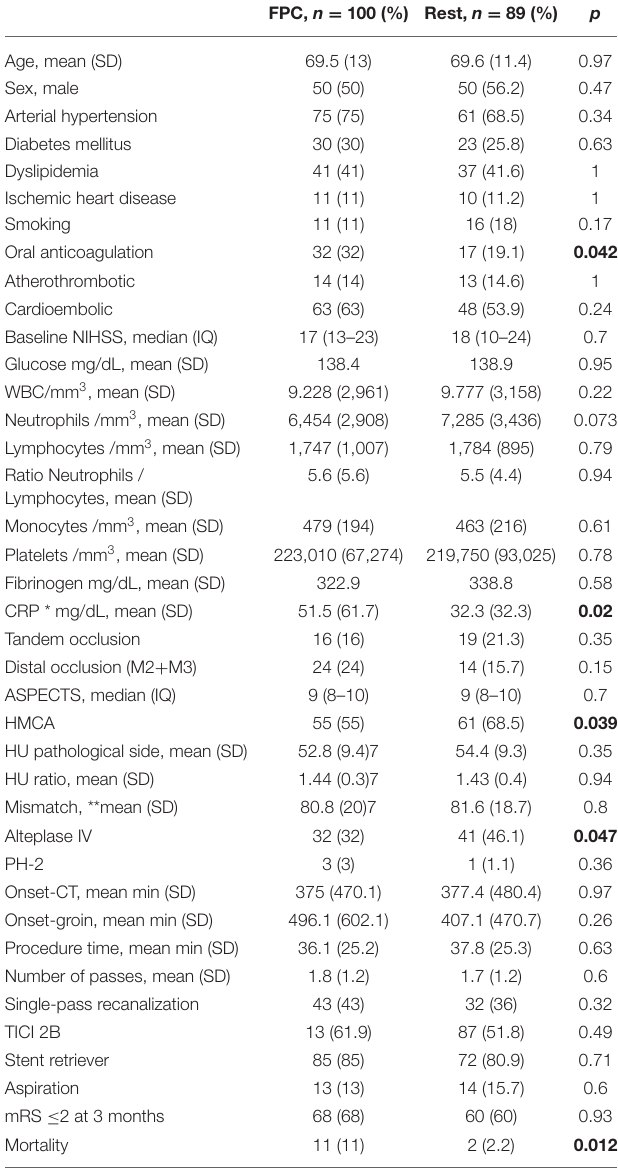
TABLE 1 | Distribution of clinical, laboratory, and radiological variables in patients with fibrin-predominant clot (FPC) vs. the rest. FPC, n = 100 (%) Rest, n = 89